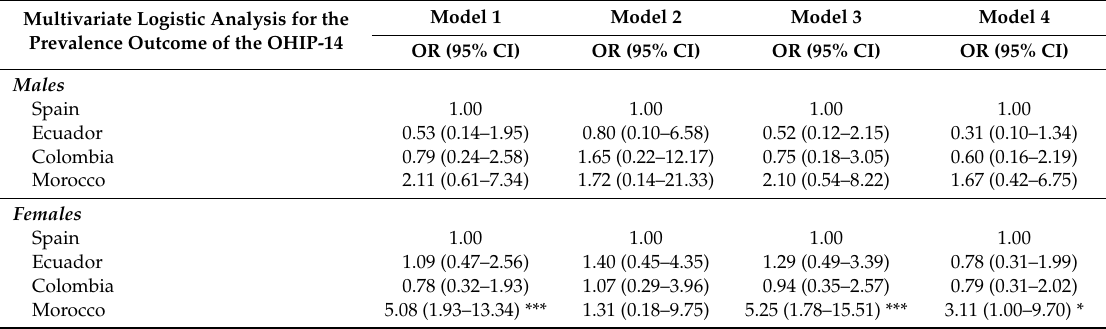
Table 6. Association between the prevalence outcome of the OHIP-14 and country of origin by means of multivariate analysis in the PELFI cohort, Spain (n =